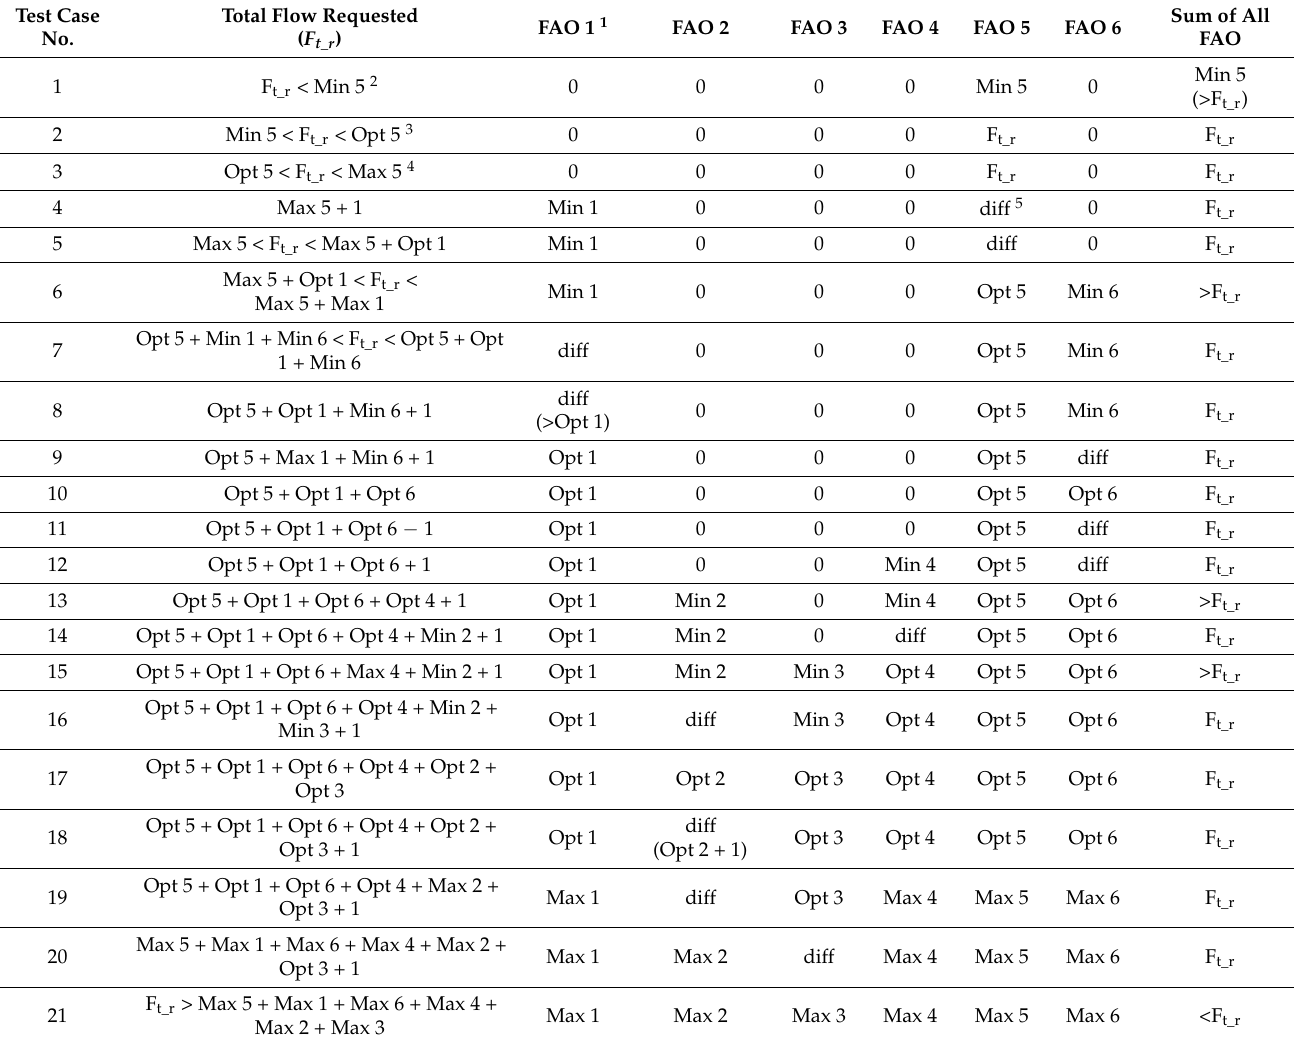
Table 5. The test cases executed and their results, in the first test